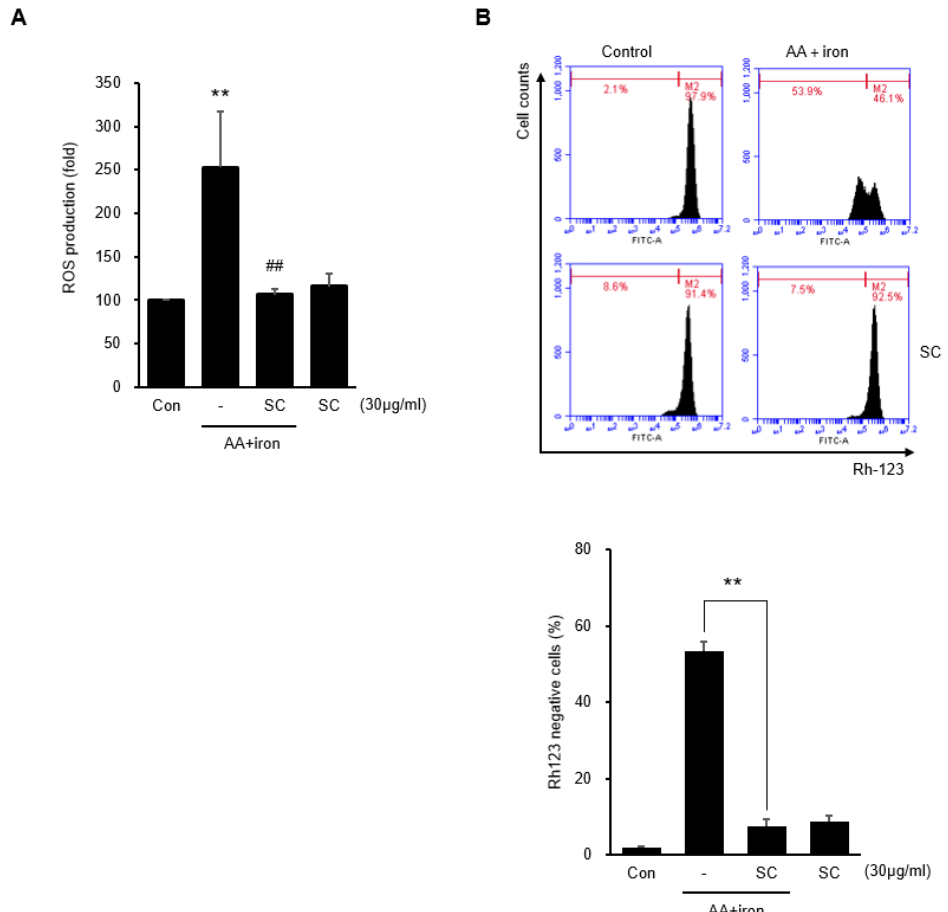
Figure 2. Effect of SC on AA + iron-induced ROS generation and mitochondrial dysfunction. HepG2 cells were treated, as described in Figure 1D. ( A ) Cellular ROS production was measured by DCFH- DA; ( B ) mitochondrial membrane permeability (MMP) was measured by flow cytometry. The cells were treated as described in Figure 1D and stained with rhodamine 123 (0.05 μg/mL) for 1 h. All data represent the mean ± SD (** p < 0.01 between control and AA + iron-treated cells; ## p < 0.01 between AA + iron and AA + iron-treated cells with SC).